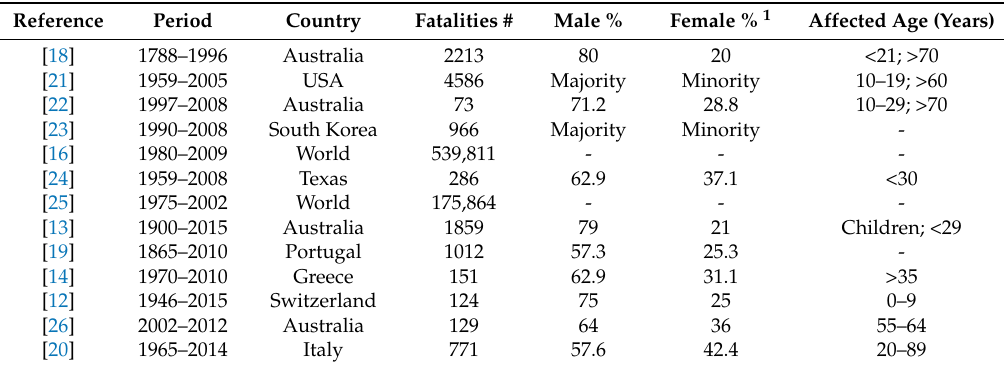
Table 1. Review of papers containing data on flood